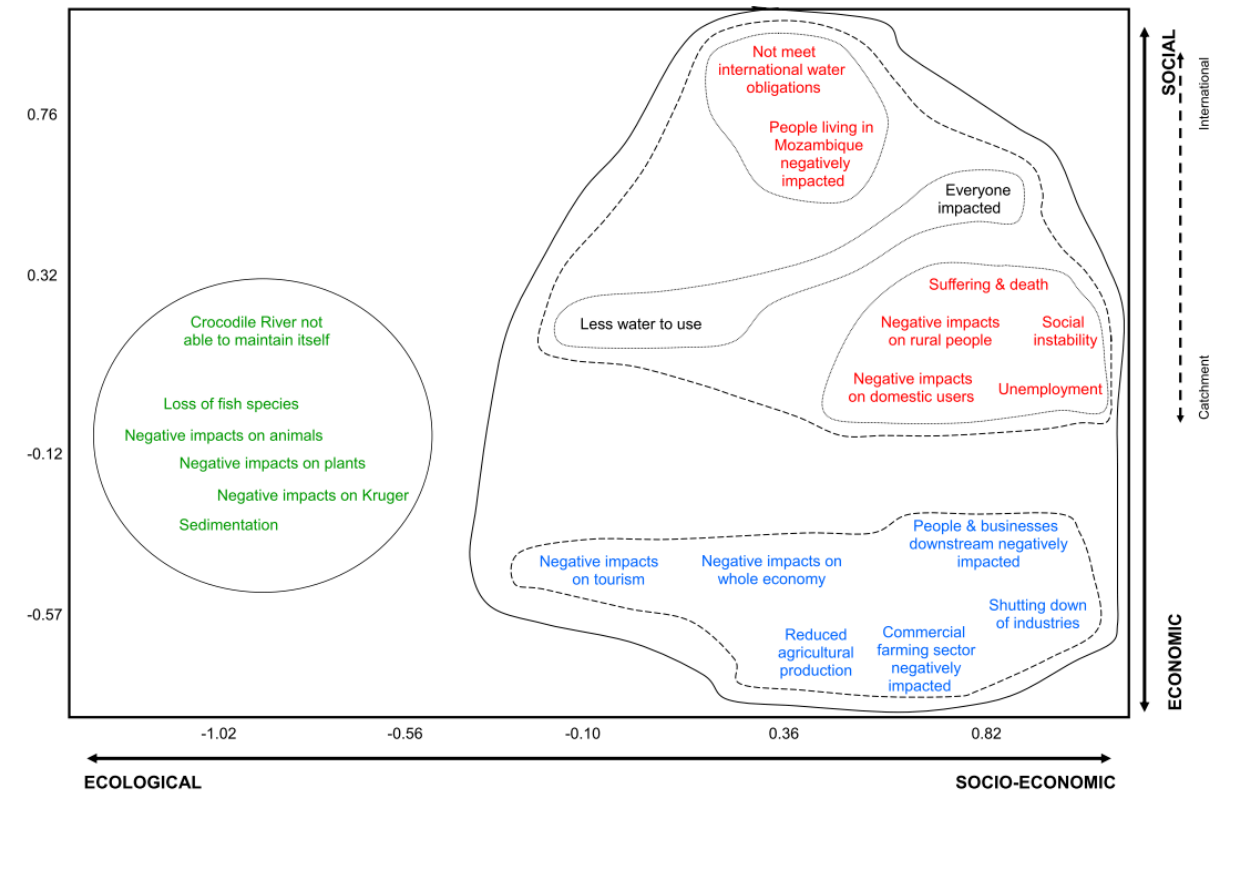
Fig. 8 . A two-dimensional MDS map of consequences, based on how similarly they were perceived by irrigators and conservationists (stress =